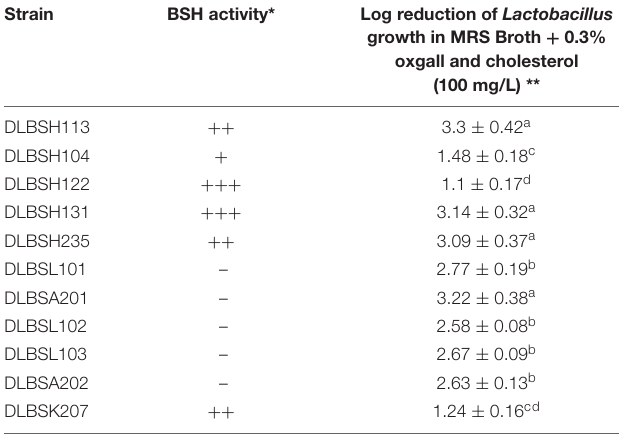
TABLE 3 | BSH Activity and Growth of Lactobacillus in the presence of 0.3% oxgall and cholesterol (100 mg/L). Strain